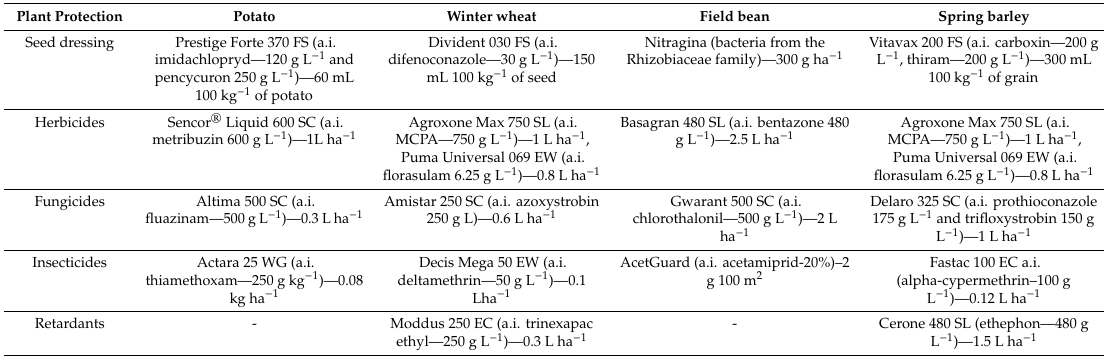
Table 5. List of plant protection chemicals included in the conventional